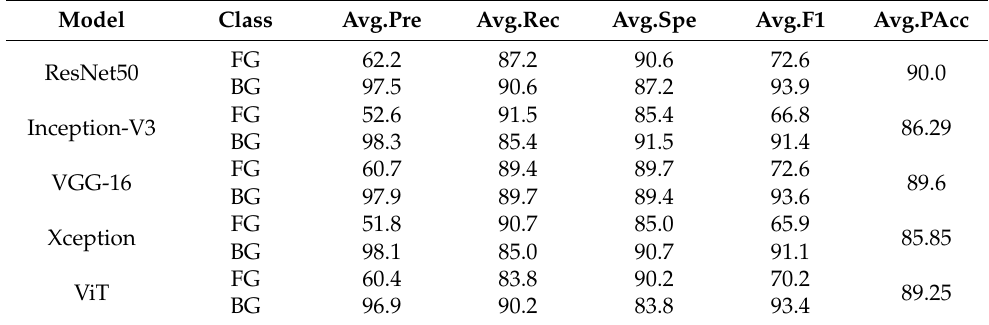
Table 5. Classification performance of models of five-fold cross-validation experiment on test set of 8 × 8 pixels’ patches. PAcc (prediction accuracy), FG (foreground) and BG (background) (In [%]).